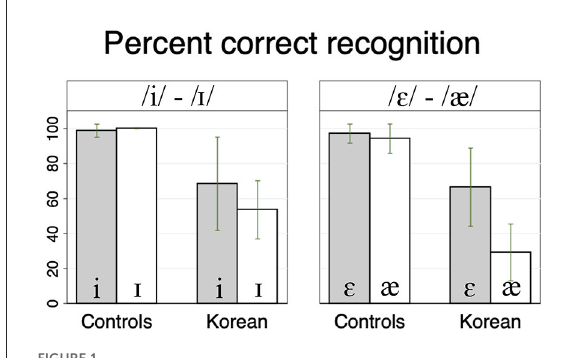
FIGURE1 Percent Alexa correctly recognized each of the four English vowels produced by native controls and Korean